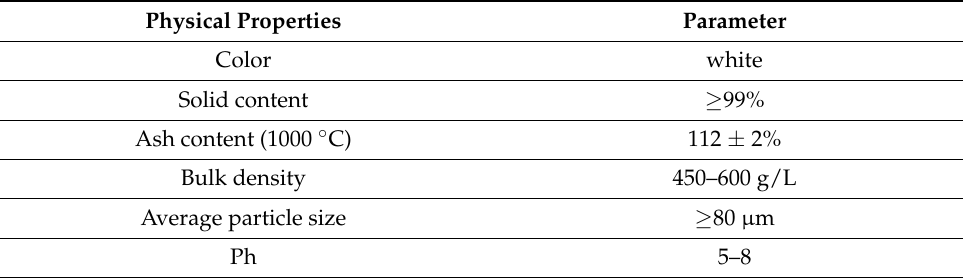
Table 4. Physical properties about the EVA polymer.